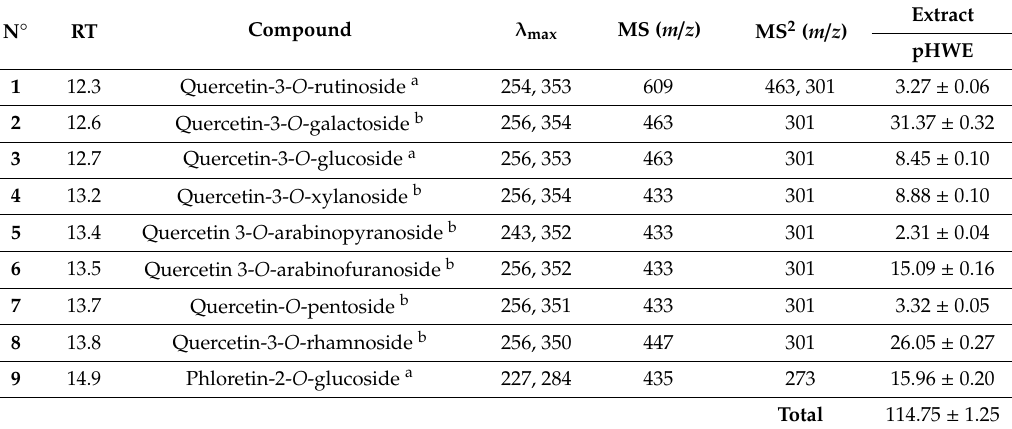
Table 2. Retention time (RT), mass spectrum (MS), and polyphenolic composition (mg / g of extract) of